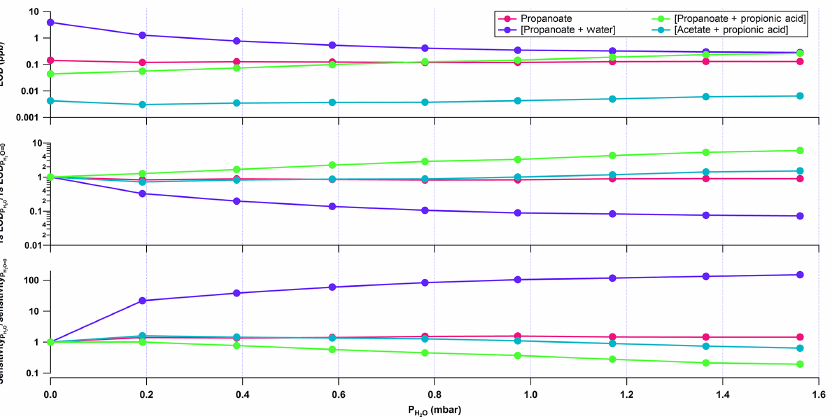
Figure 7. The propionic acid data used in Fig. 6 at a dV = 2 are replotted as a function of water vapor content in the IMR. Top: the calculated values for the limit of detection for propionic-acid-related ions ( S/N = 3, 1s integration). Middle: the limit of detection ( S/N = 3, 1s integration) relative to the limit of detection under dry conditions. Bottom: the change in sensitivity relative to the sensitivity under dry